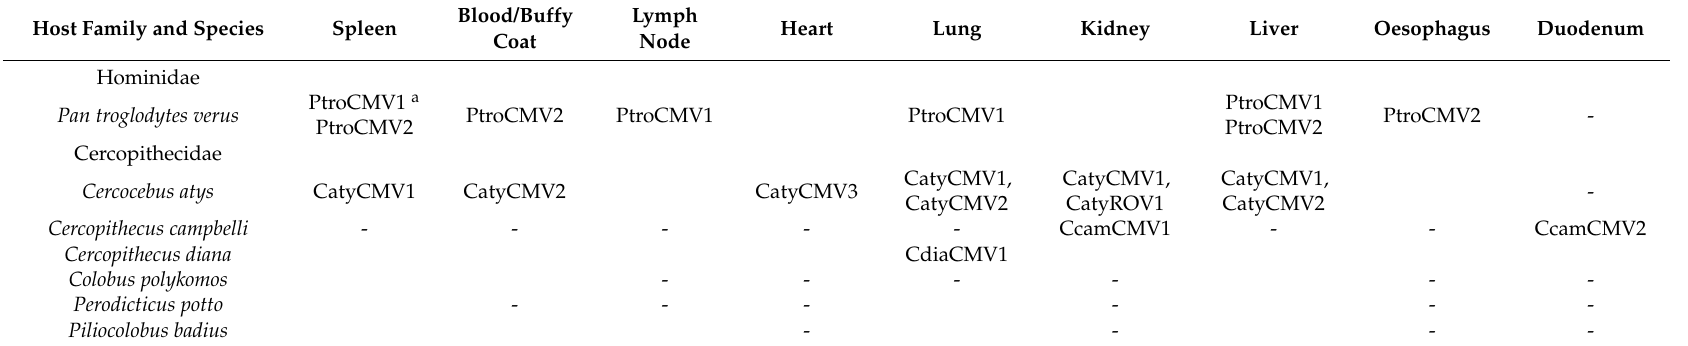
Table 4. Cytomegaloviruses in organs and blood of nonhuman primates in Taï National Park, C ô te d’Ivoire. Host Family and Species